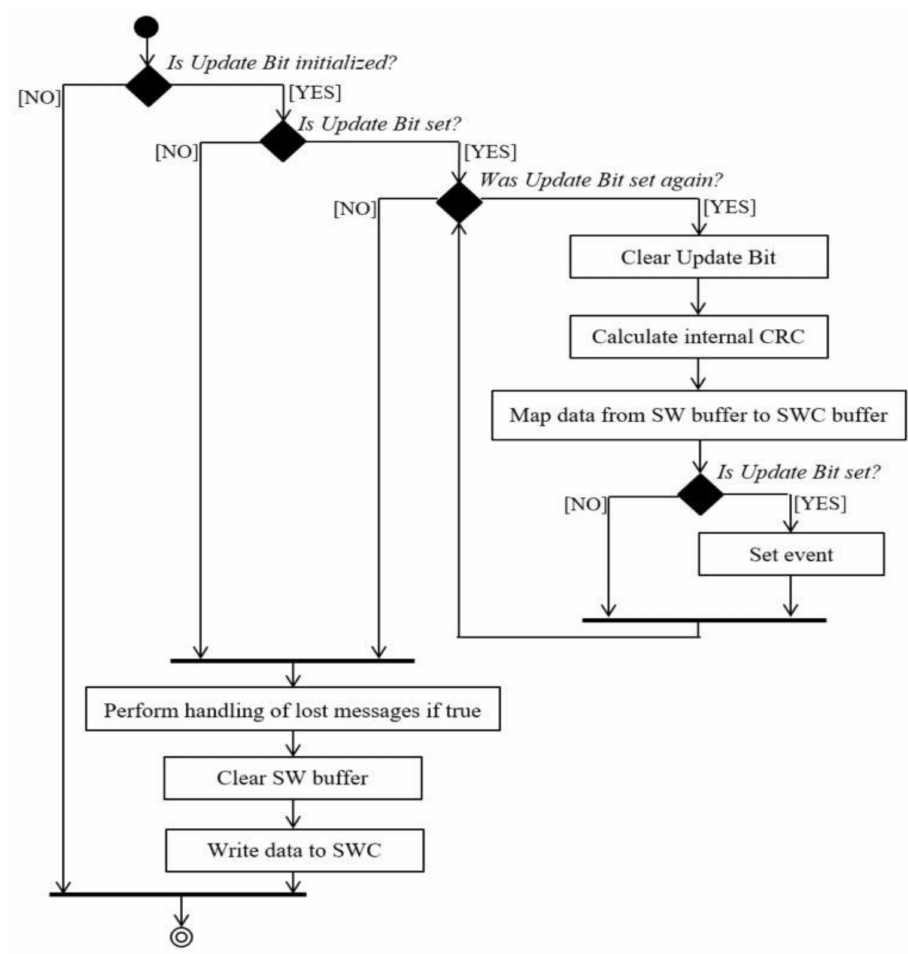
Figure 11. Processing the received